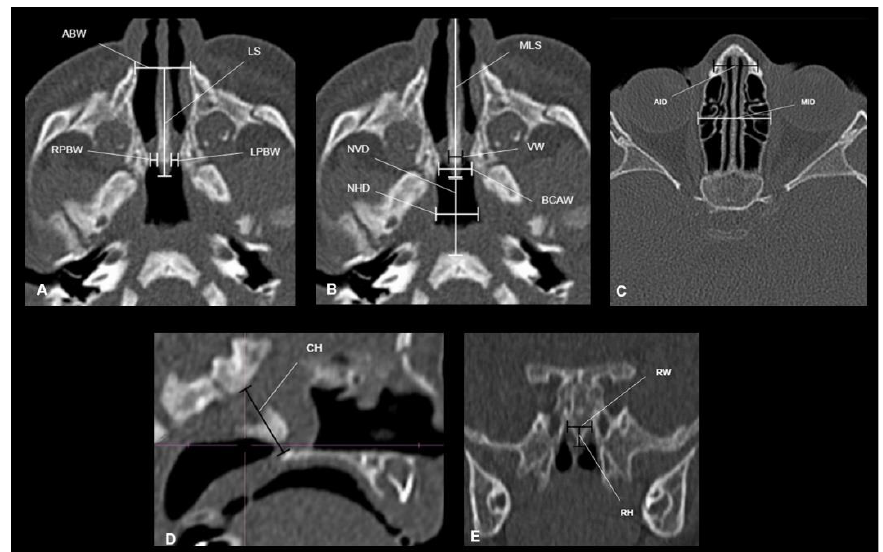
Figure 1. ( A – C ) Summary of measurements in the axial plane (LS: Septum length; ABW: Anterior bone width; RPBW: Right posterior bone width; LPBW: Left posterior bone width; MLS: Maximum septum length; VW: Septum thickness; BCAW: Choana bone width; NVD: Vertical distance of the nasopharynx; NHD: Horizontal distance of the nasopharynx). B. Summary of anterior axial plane measurements (AID: Anterior interorbital distance; MID: Mean interorbital distance). ( D ). Measure- ment of choanal height (CH) in the sagittal plane. ( E ). Measurement of the rostrum in the coronal plane (RW: rostrum width; RH: rostrum